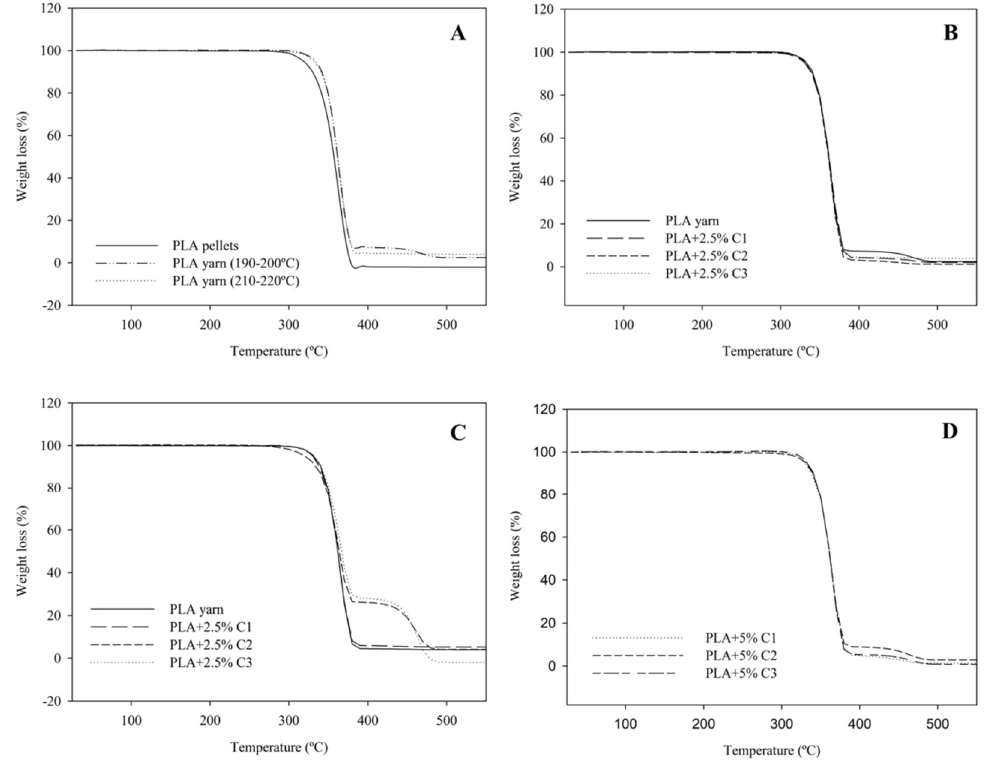
Figure 3. Thermogravimetric ( TG) curves at a heating rate of 10 °C·min − 1 of ( A ) PLA pellets and PLA processed at two different temperature ranges; ( B ) PLA + 2.5% compatibilizers processed at 190–200 °C; ( C ) PLA + 2.5% compatibilizers processed at 210–220 °C and ( D ) PLA + 5% compatibilizers processed at 210–220 °C. Table 2. Degradation temperatures (T x% ) and onset temperature (T on ) of extruded PLA samples with or without different compatibilizers.